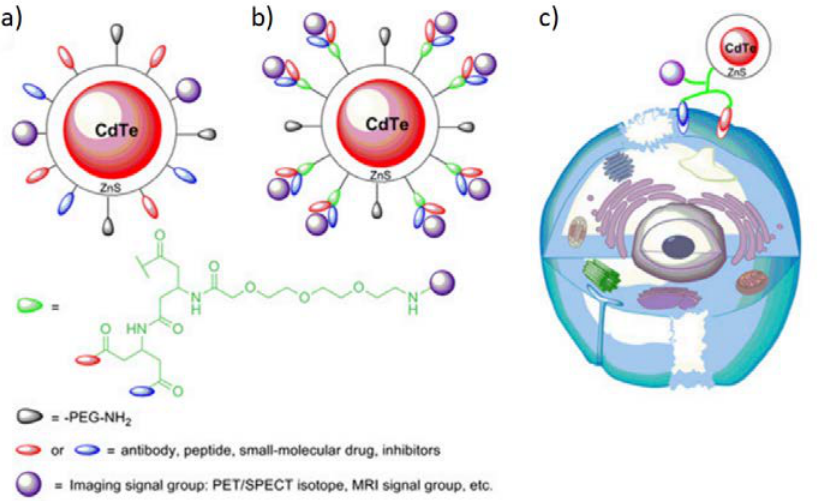
Figure 16. Representation of QD functionalized for in vivo targeting and imaging, including ( a ) the structure of a multiplex modifying multifunctional QD probe, ( b ) the structure of a single modifying multifunctional QD probe, and ( c ) the general idea of enhancing synergistic binding of the heterodimeric multifunctional QD probe. Adapted from ref. [32].